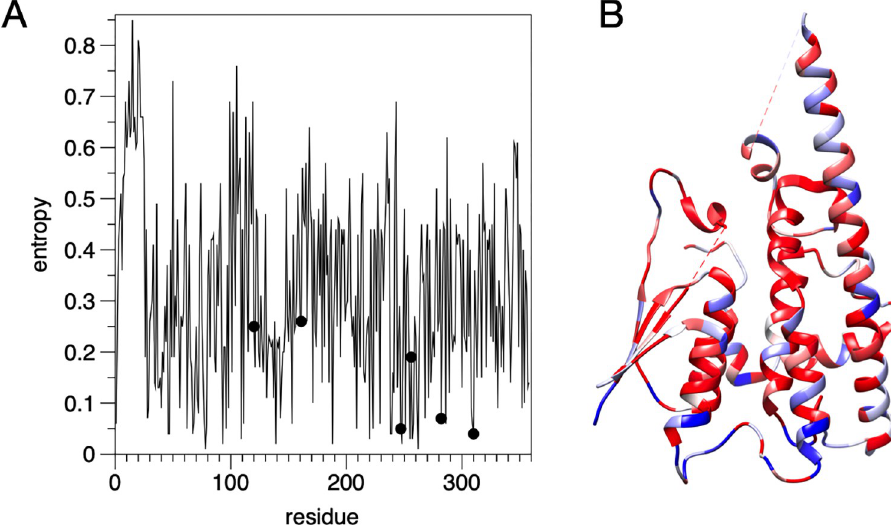
Fig 7. Sequence entropy analysis. A. Entropy plot for GDAP1. The positions of the mutations studied here are shown with dots, and these positions indicate a high level of conservation (low entropy). B. Mapping of entropy onto the GDAP1 crystal structure monomer. Blue indicates high entropy and red